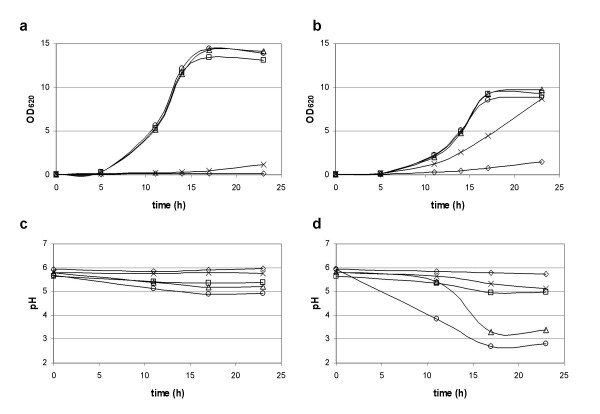
a-d. Influence of 50 mM buffer on aerobic growth of TMB 3001 [62] in YP and DM media. a, c: glucose 20 g/l in YP, b, d: glucose 20 g/l in DM. Non buffered -○-, Phthalate -□-, Phosphate -△-, Citrate-Phosphate -×-, Citrate -◊-